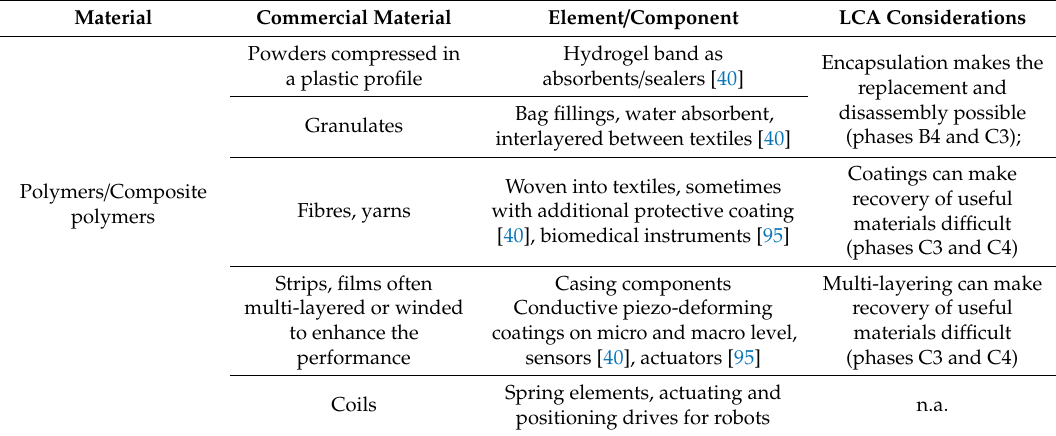
Table 8. Qualitative LCA considerations on adaptive polymer